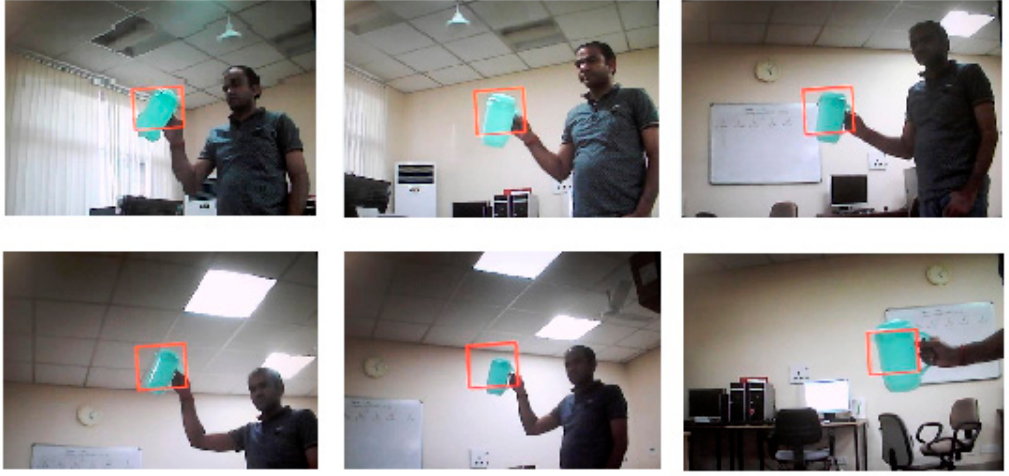
Figure 17. Frame sequence showing object tracking in scenes that change due to camera movement.